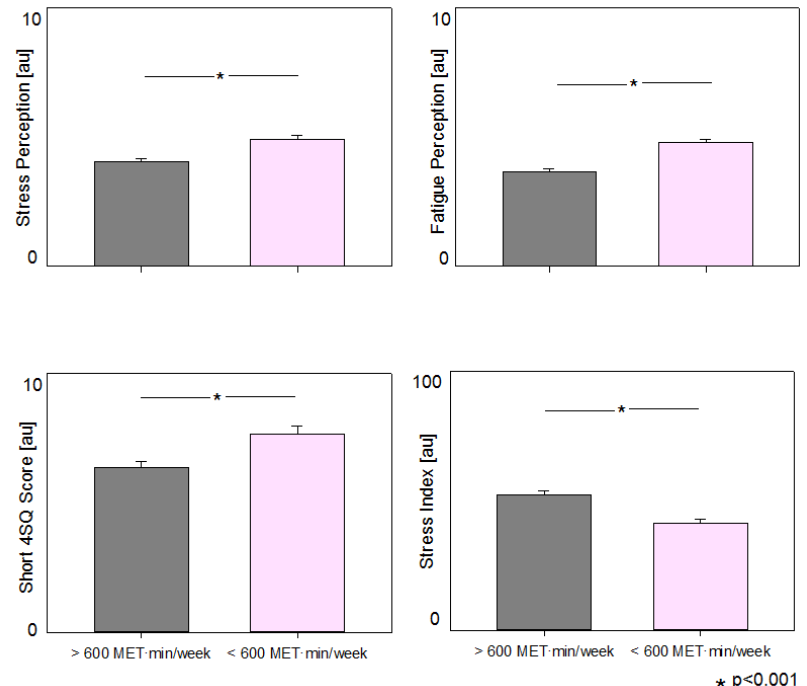
Figure 1. Perception of Stress, Fatigue, Subjective Stress-Related Somatic Symptoms (4SQ) and Stress Index in employees meeting current physical activity recommendations (Above 600 [MET·minutes/week) ( left bars) and those who did not (Below 600 [MET·minutes/week) ( right bars). Note that Stress Index (combination of scores of somatic symptoms, stress and fatigue perception) was built so that higher scores being healthier.